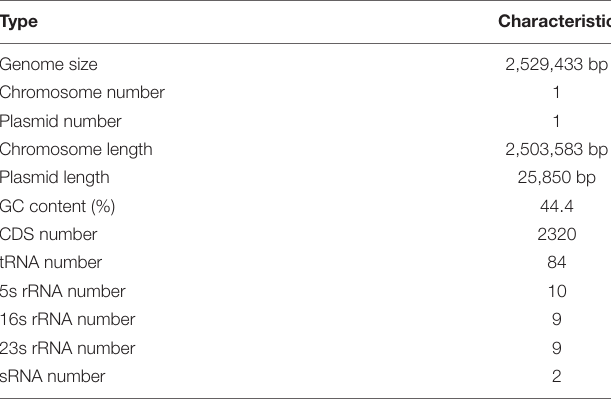
TABLE 1 | General features of Weissella confusa LM1